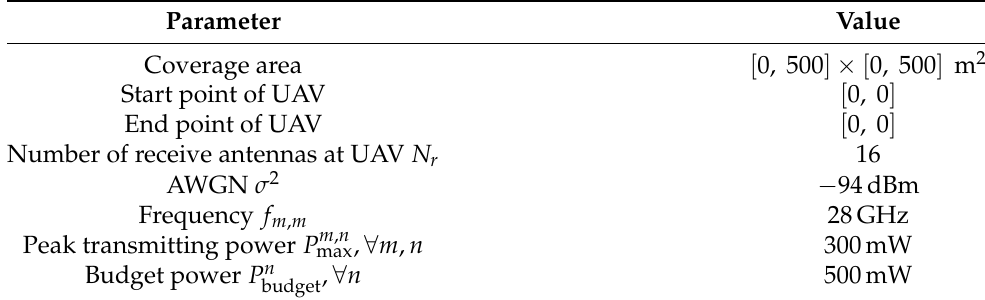
Table 2. Default System Parameters.